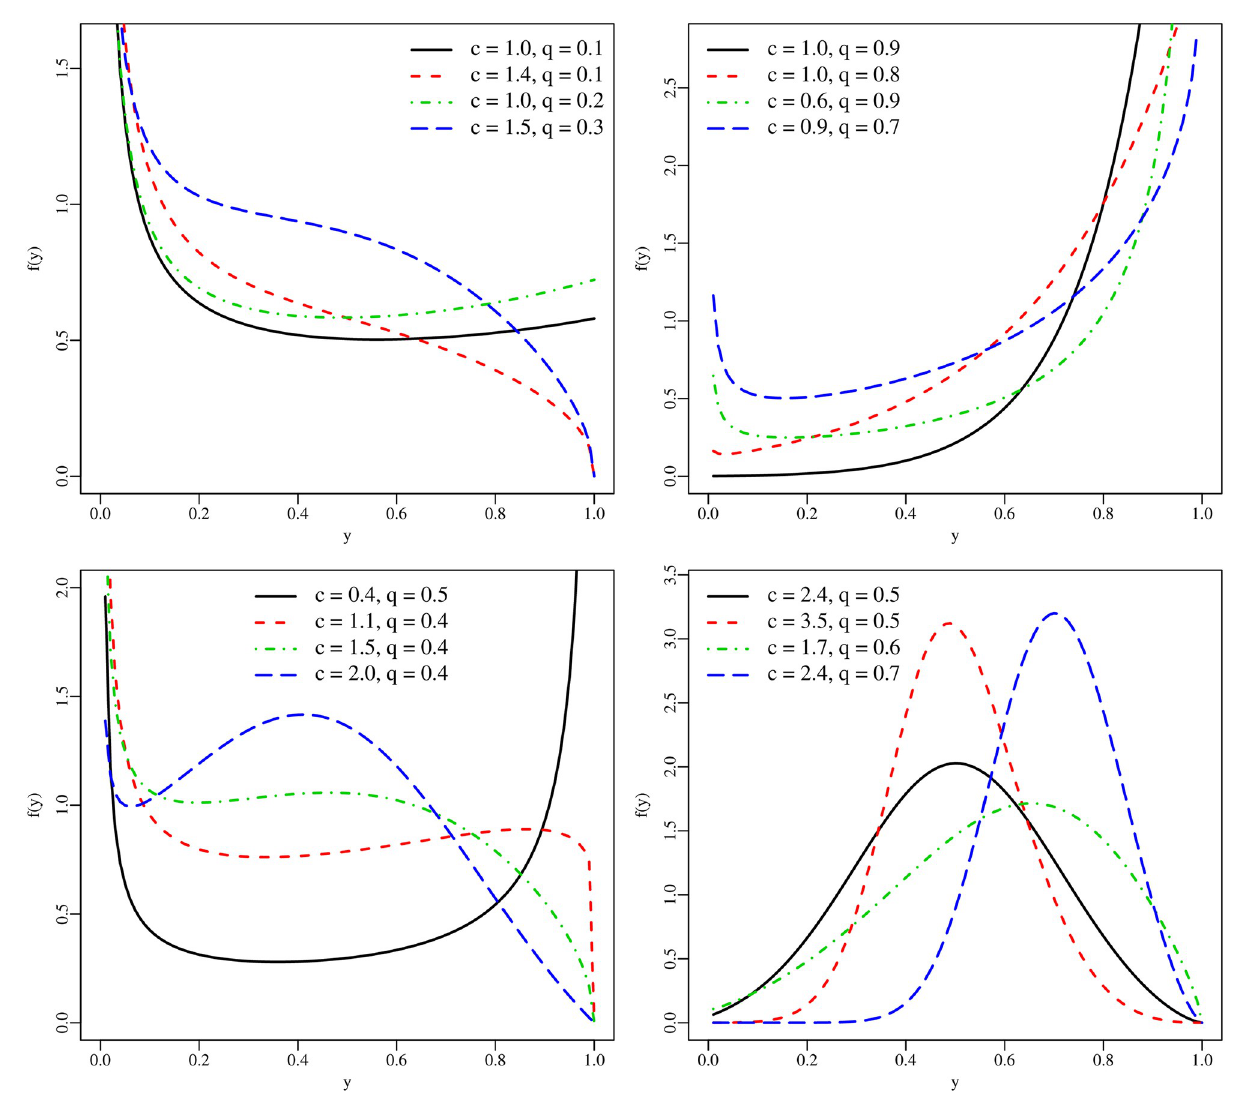
Fig 1. Plots of the UBXII density (with τ =